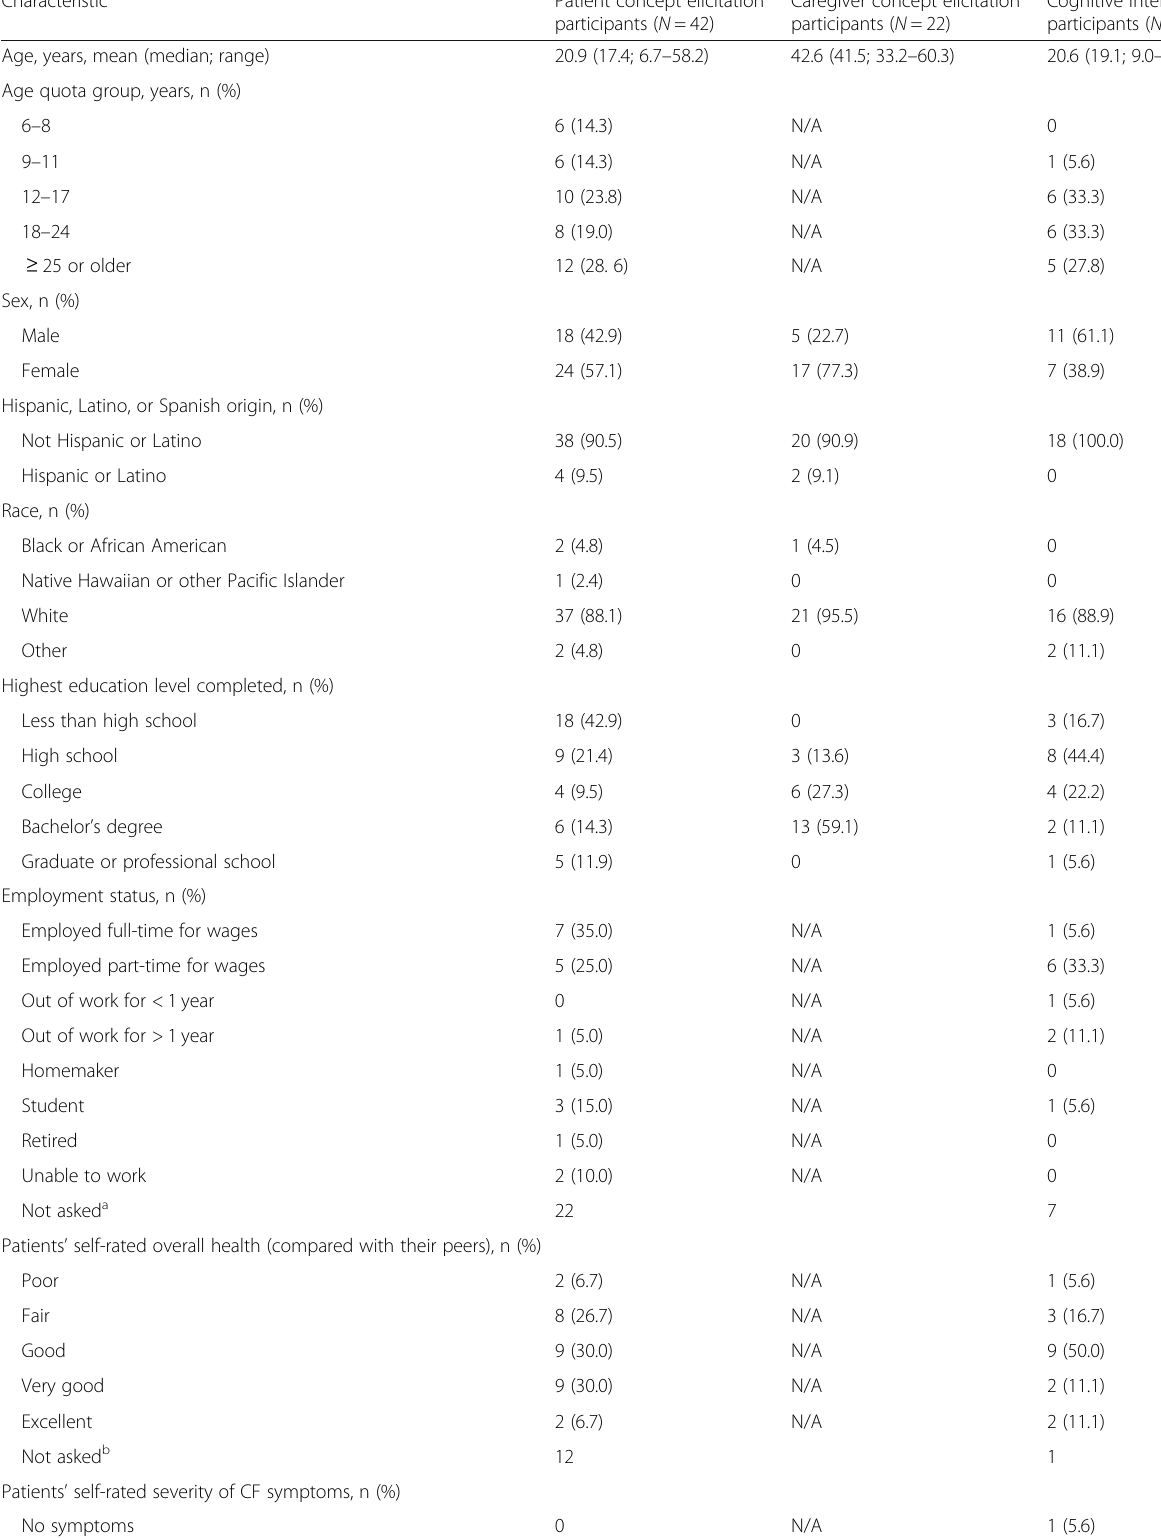
Table 1 Participant demographic and clinical